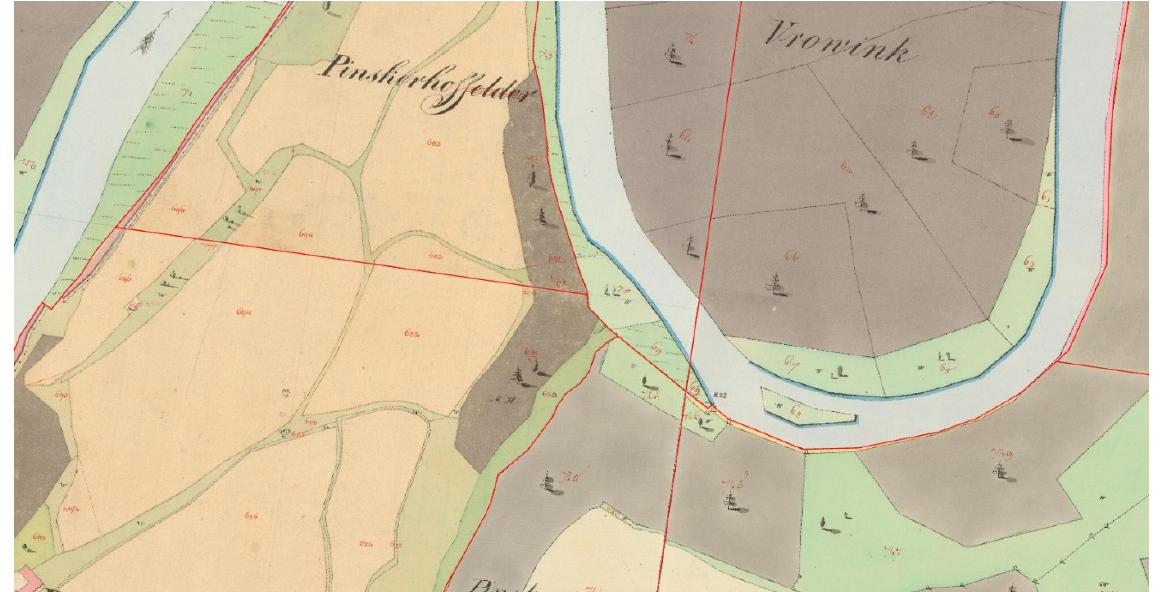
Figure 6. Visual problems at the borders of cadastral areas, Source: author’s elaboration.